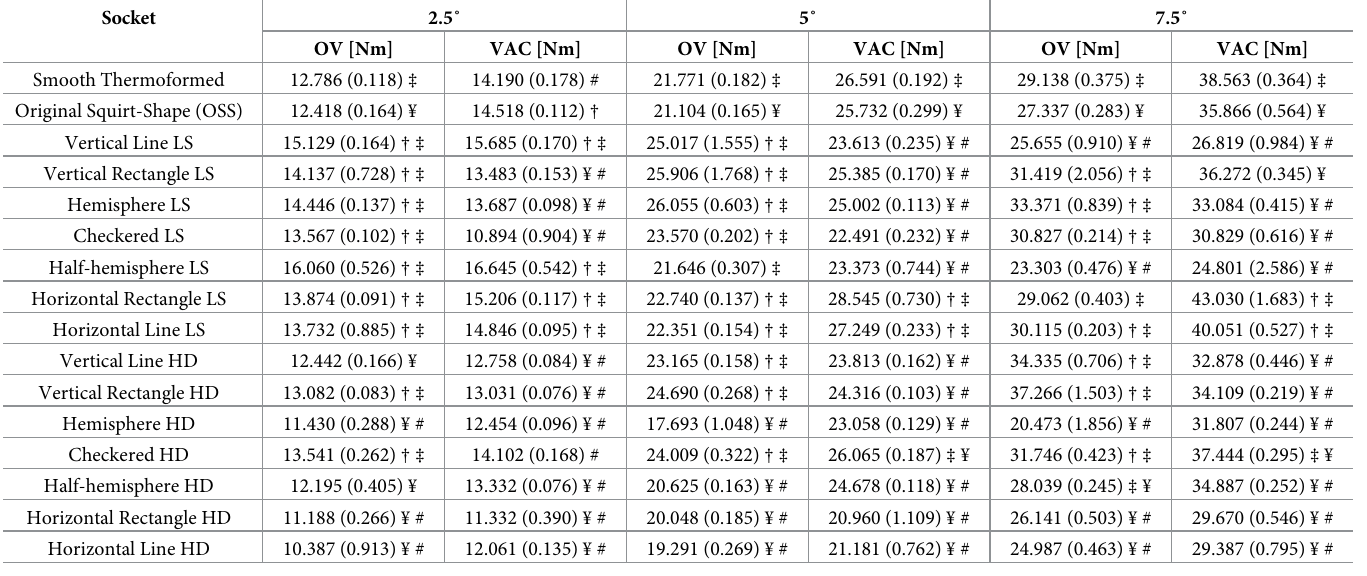
Table 1. Absolute Mean and Standard Deviation (SD) for torque at each rotation angle for both suspension conditions (OV: passive suction with one-way valve; VAC: active vacuum suspension at 20 inHg (67.73 kPa); Nm: Newton meter; LS: light and sparse; HD: heavy and